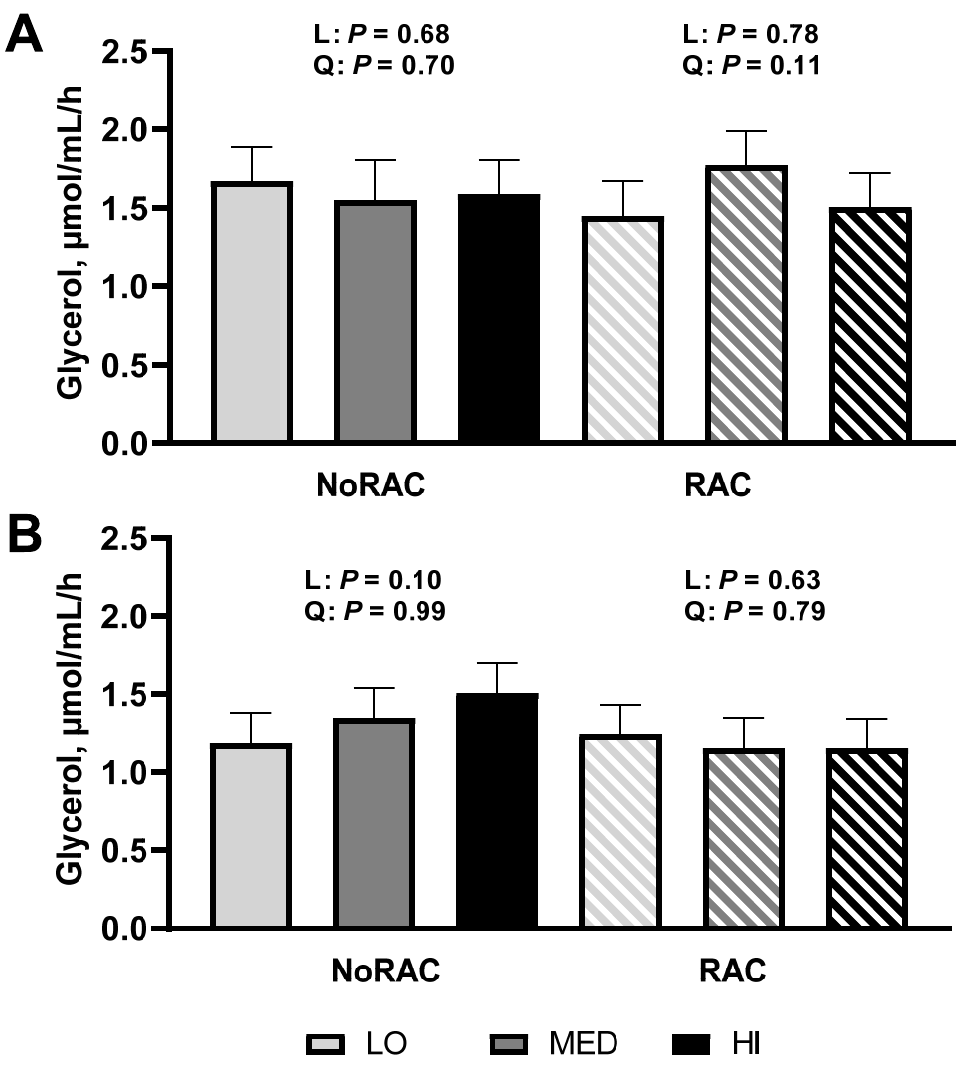
Figure 1. In vitro lipolytic rate of adipose tissue from steers fed 0, 10, or 20 mg Cu/kg DM for LO, MED, and HI, respectively, and 0 (NoRAC) or 300 (RAC) mg · steer − 1 · day − 1 of ractopamine hydrochloride. Adipose samples were collected on day 66 or 67 (day 6 or 7 of RAC feeding). ( A ) Basal (unstimulated) in vitro lipolytic rate of adipose tissue tended to quadratically increase due to Cu supplementation within RAC steers ( p = 0.11). No further linear or quadratic effects were observed ( p ≥ 0.68). ( B ) Epinephrine stimulated in vitro lipolytic rate tended to linearly increase with Cu supplementation within NoRAC ( p = 0.10). No other linear or quadratic responses were observed ( p ≥ 0.63) in stimulated lipolysis. Effects of Cu within NoRAC are denoted as L (linear) and Q (quadratic) and effects of Cu within RAC are denoted as L-R (linear) and Q-R (quadratic).